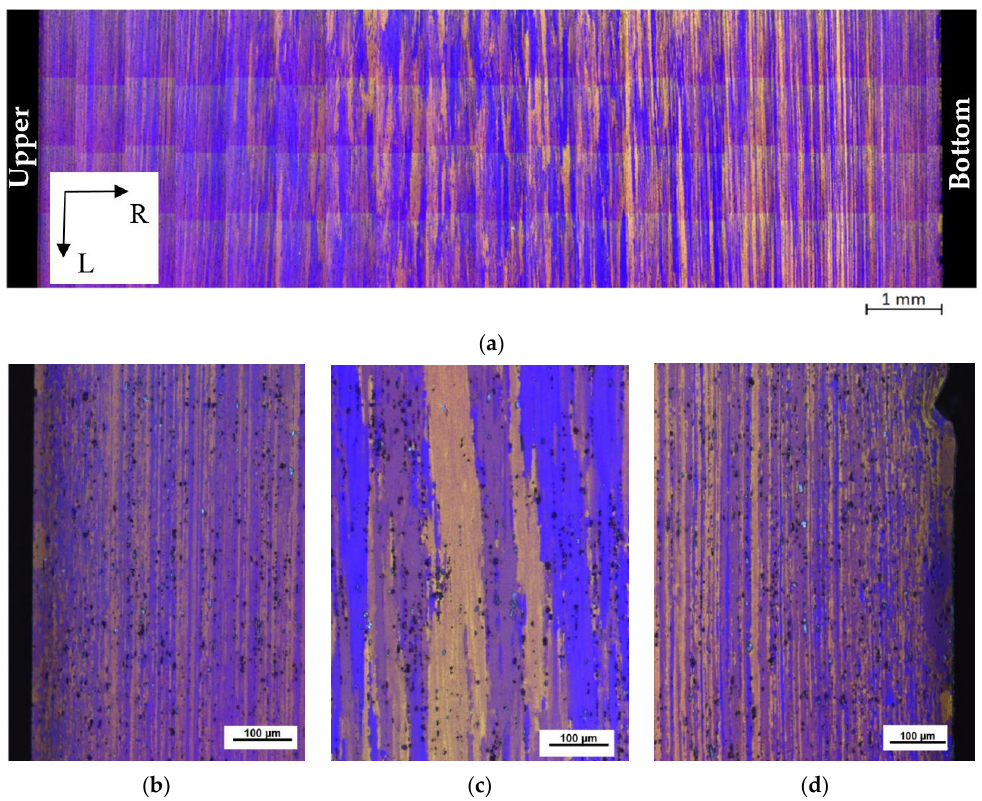
Figure 5. Light micrographs of the QS material taken on the section corresponding to the LR plane: ( a ) overall image of the microstructure; ( b ) first and ( d ) second surface sections showing long, thin grains near the surface; ( c ) massive grains in the wire center (Barker’s etching was used). Scanning electron micrographs of the QS sample, taken on the LR section, are shown in Figure 6a (surface region) and Figure 6b (central region). The QS material exhibits a fibrous microstructure